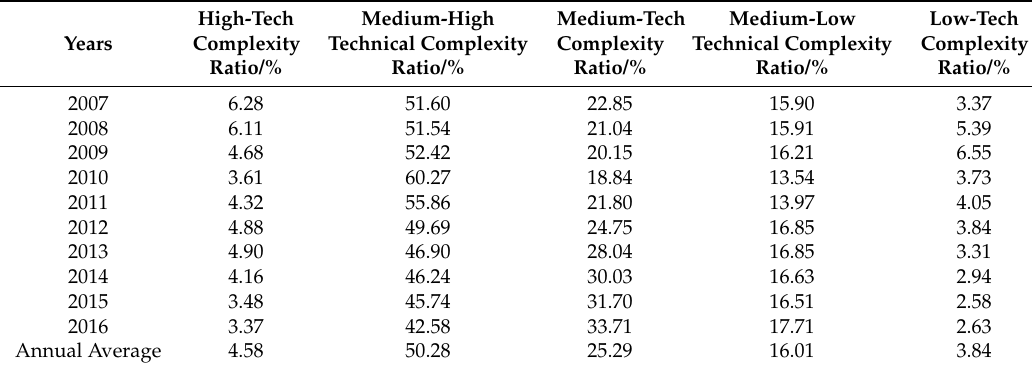
Table 3. Dynamic distribution of export technology structure of China’s